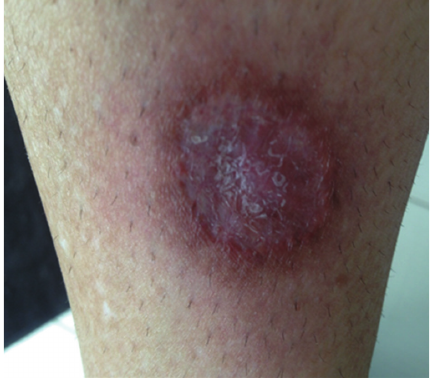
Figure 8: After treatment with 7 weeks of prednisone and azathio-